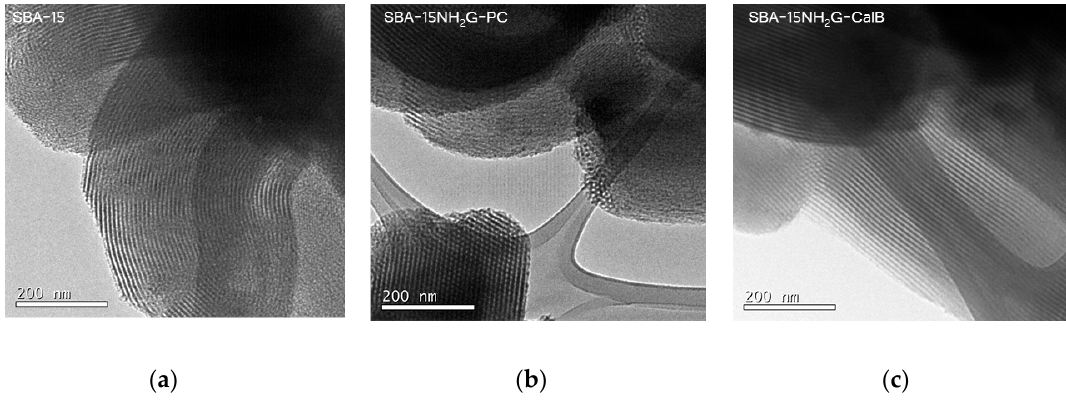
Figure 2. TEM micrographs: ( a ) SBA-15, ( b ) SBA-15-NH 2 G-PC, ( c ) SBA-15-NH 2 G-CalB.